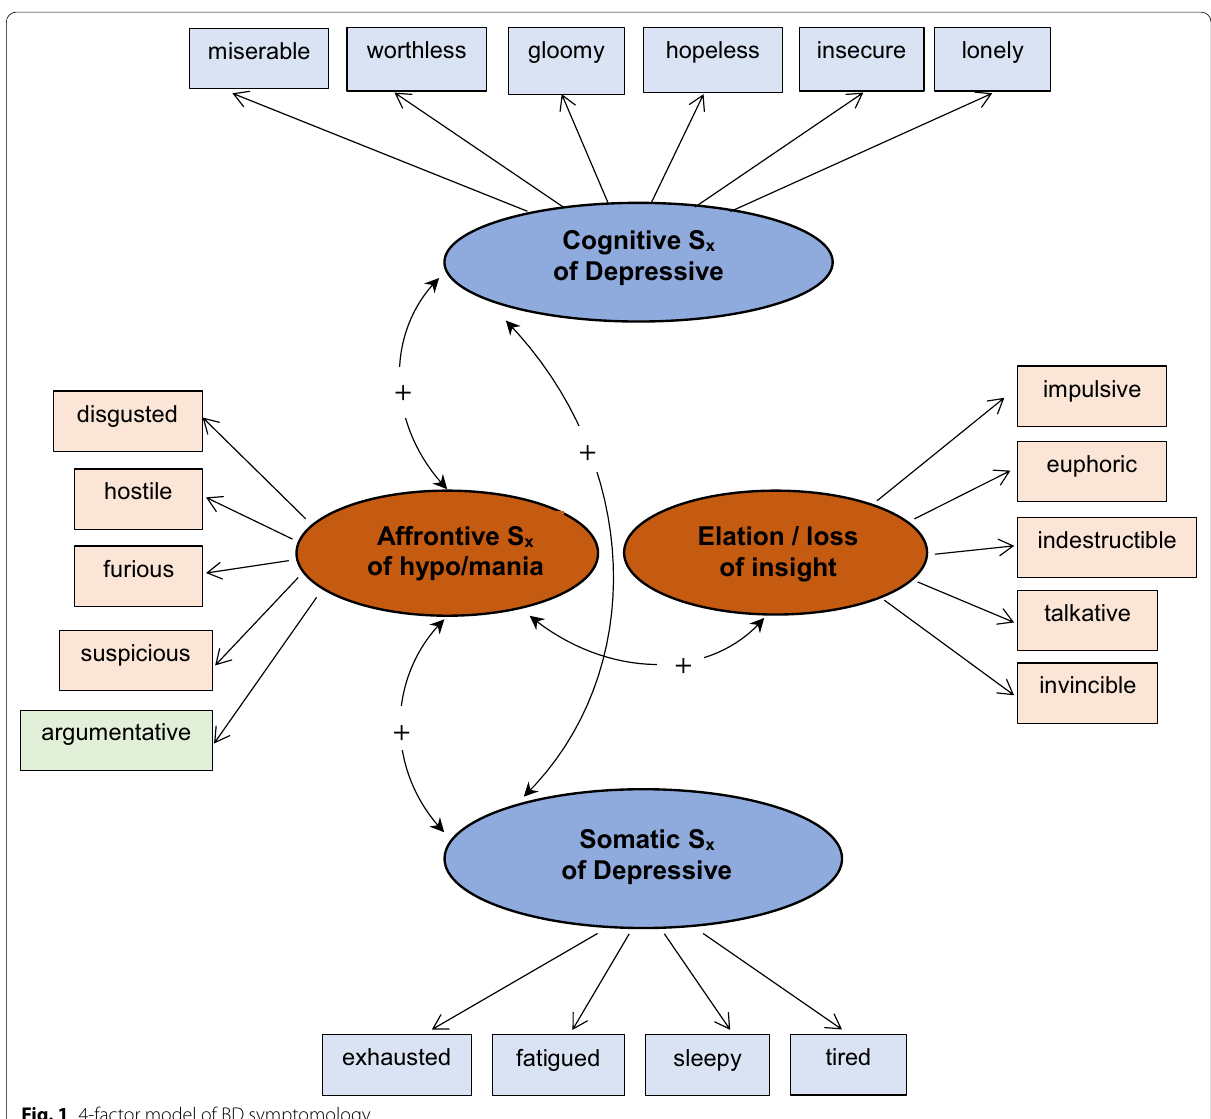
Fig. 1 4-factor model of BD